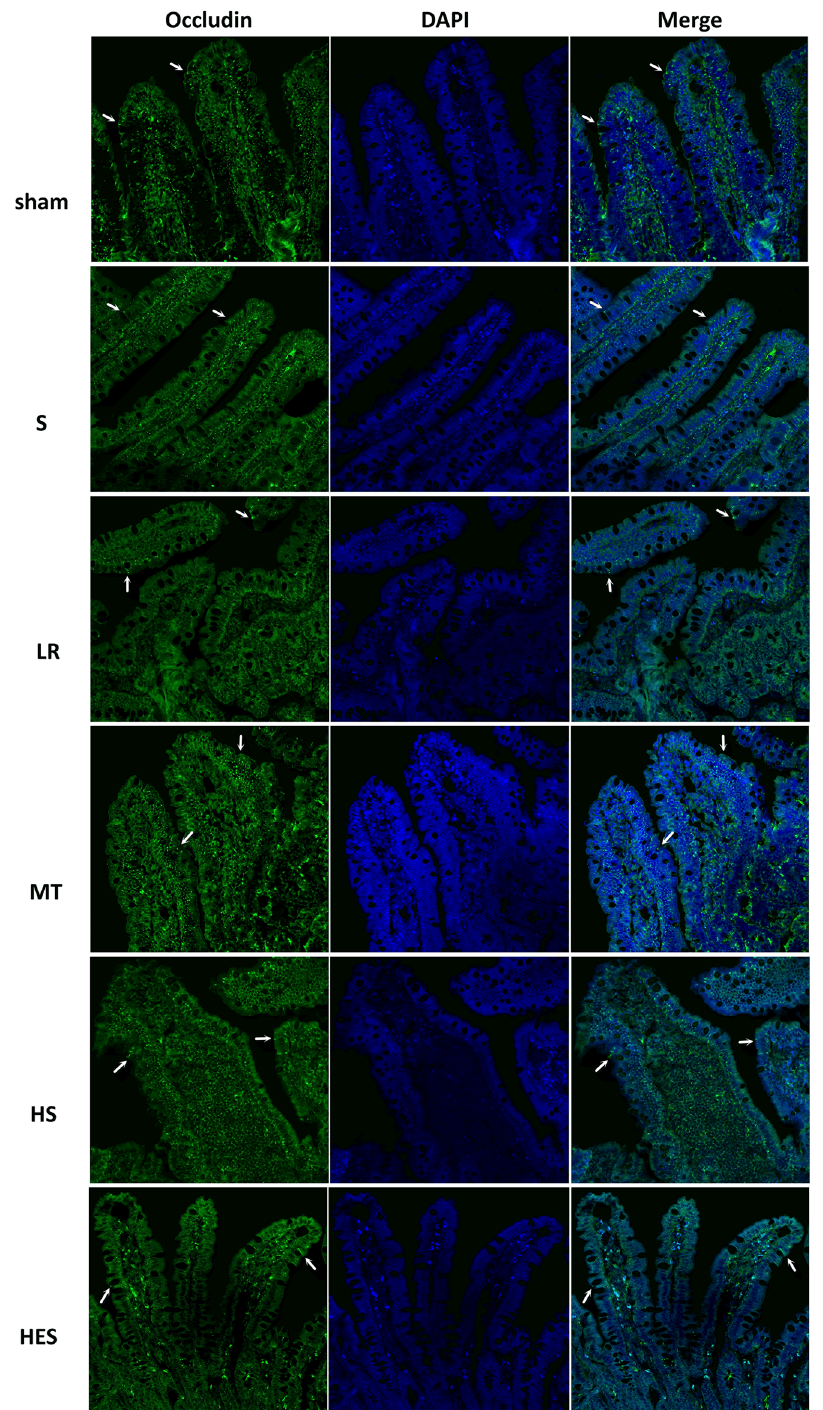
Fig 6. Representative micrographs of distribution of occludin between groups. The tight junctions protein Occludin (green) and nuclei (blue) images were obtained by immunofluorescence analysis of tissue sections of rats jejunums (200X). Arrows indicate areas of staining. Sections from at least 4 mice were examined for each condition.